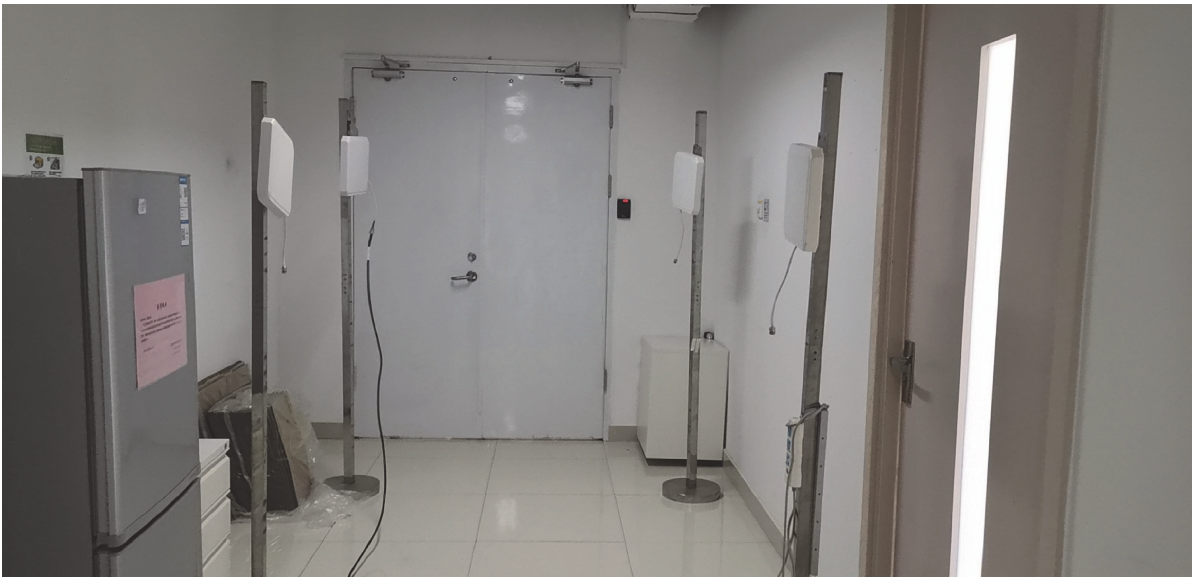
Figure 18: Small test area.